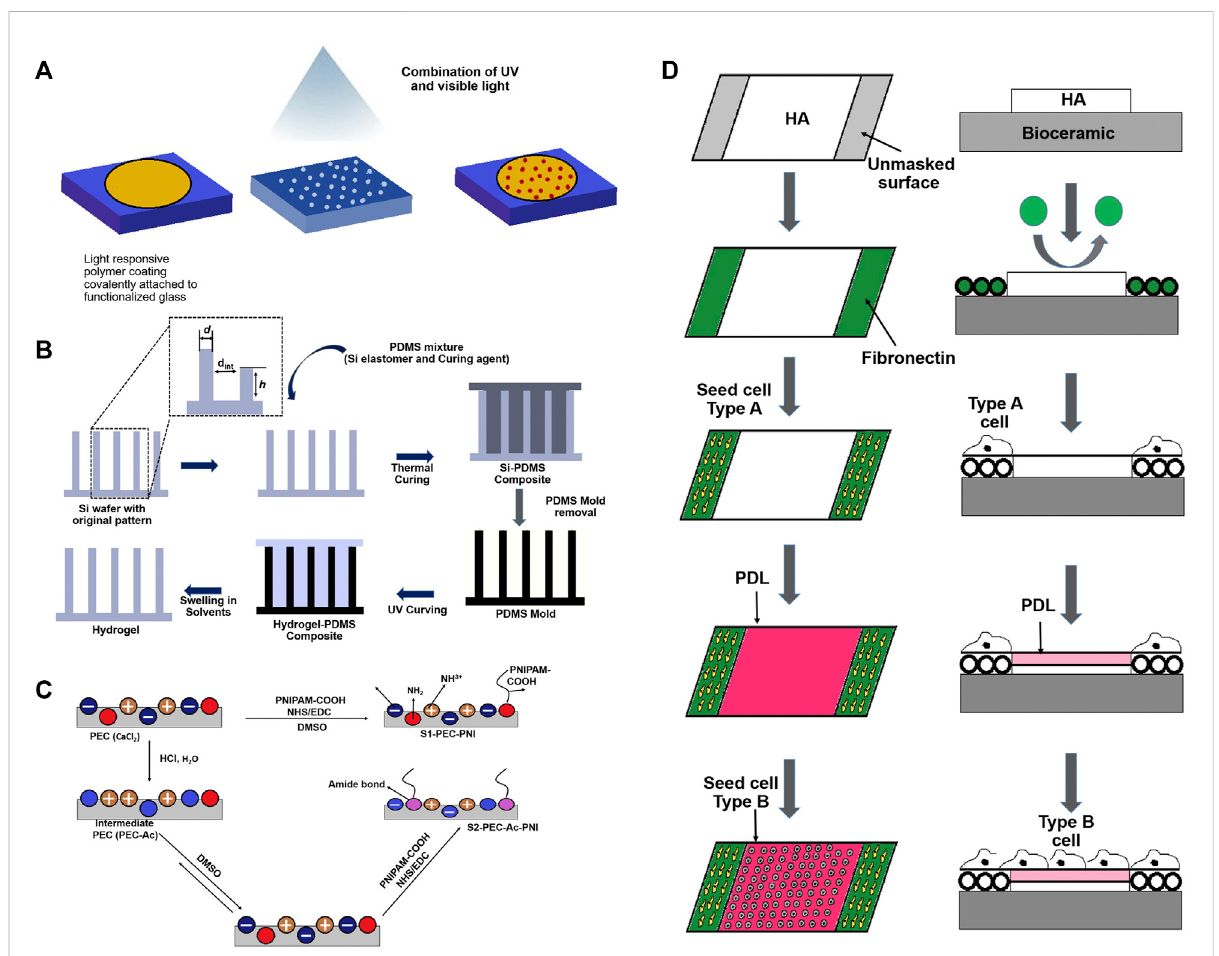
FIGURE 5 Different surface modi fi cation techniques of scaffolds for cell adhesion and proliferation: (A) Mask illumination; (B) ; Soft lithography; (C) EDC- NHS Coupling; (D) Deposition of HA-PLL.